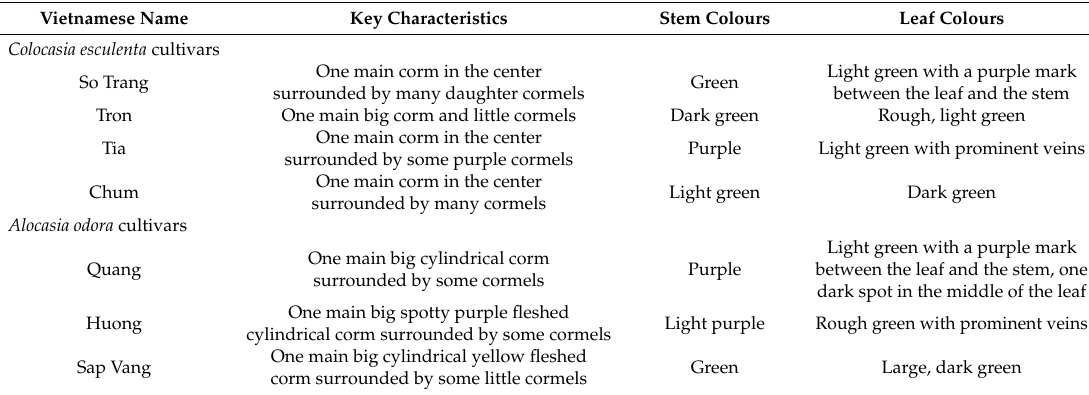
Table 1. Vietnamese and scientific names and key characteristics of common taro cultivars grown in central